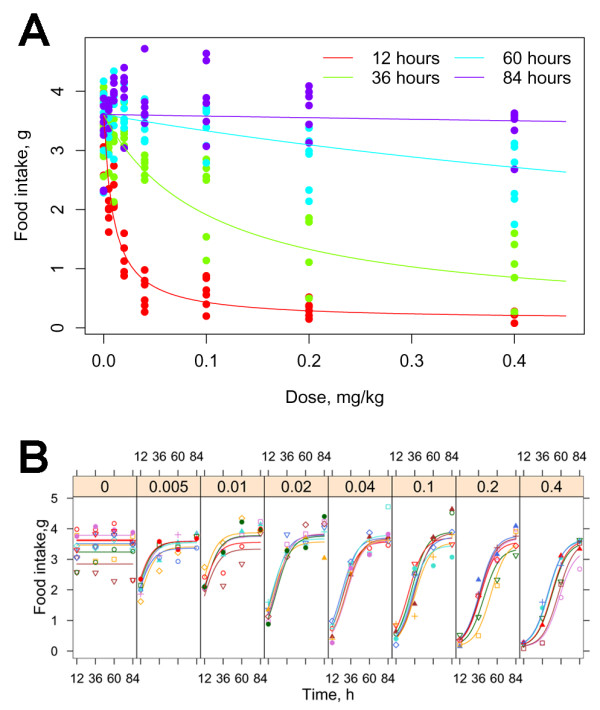
Effect of endotoxin dose over time.A. The fitted dose-response curves for food intake are shown for the four nights after injection illustrating the increase in median effective dose each night. B. Time-dependent food intake curves are shown for the individual mice at each dose. (n= 6 mice per dose)